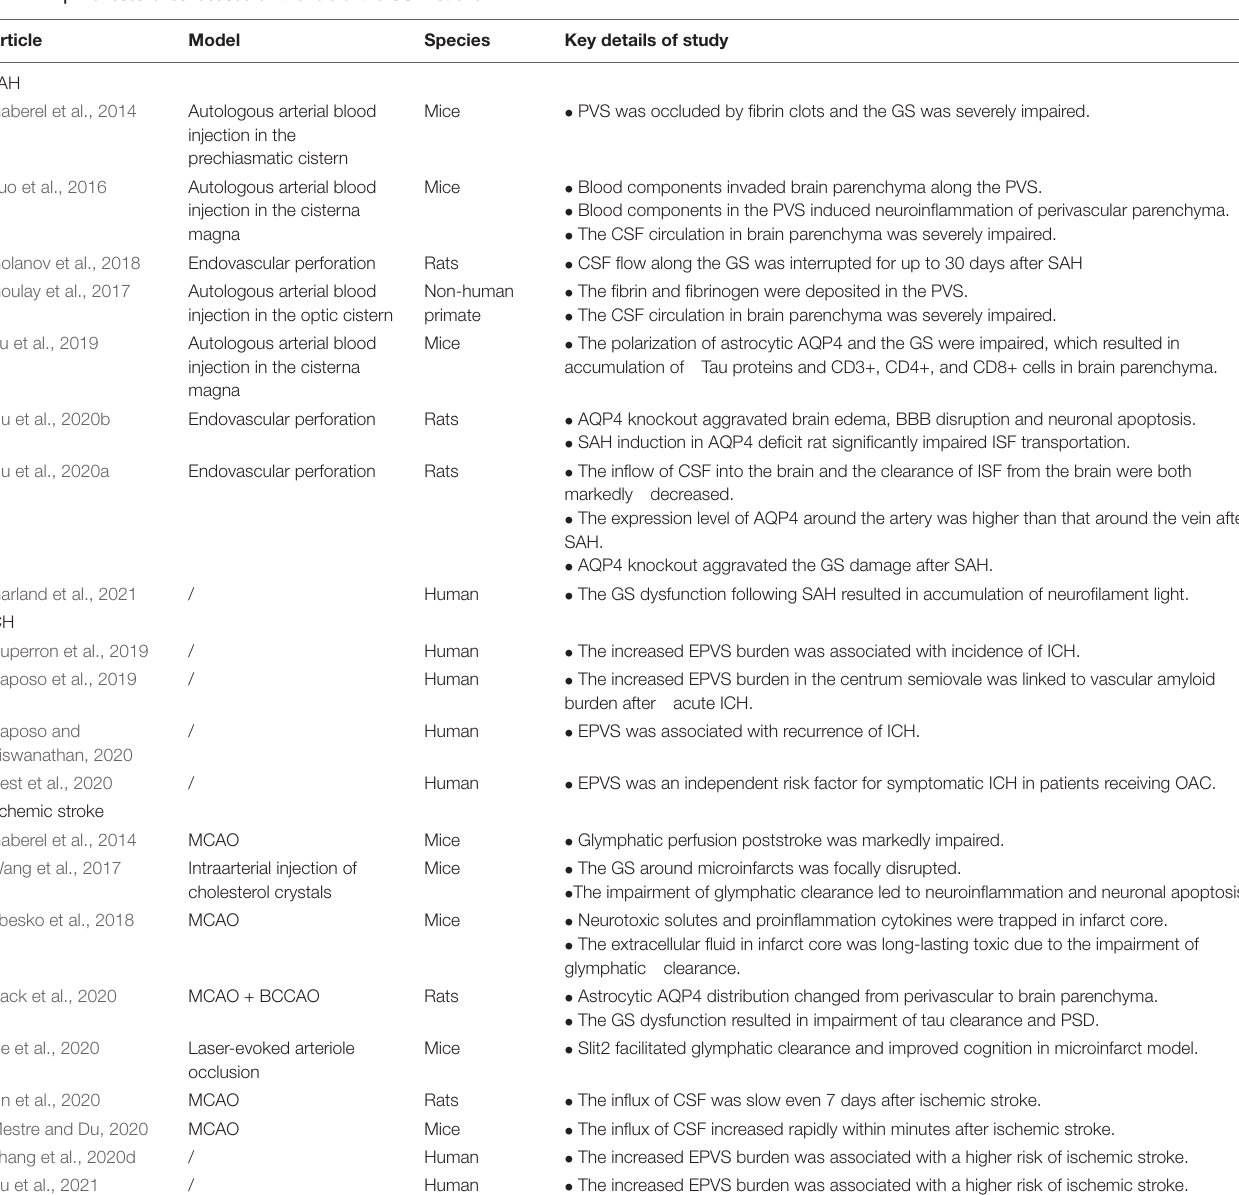
TABLE 1 | The researches focused on the role of the GS in